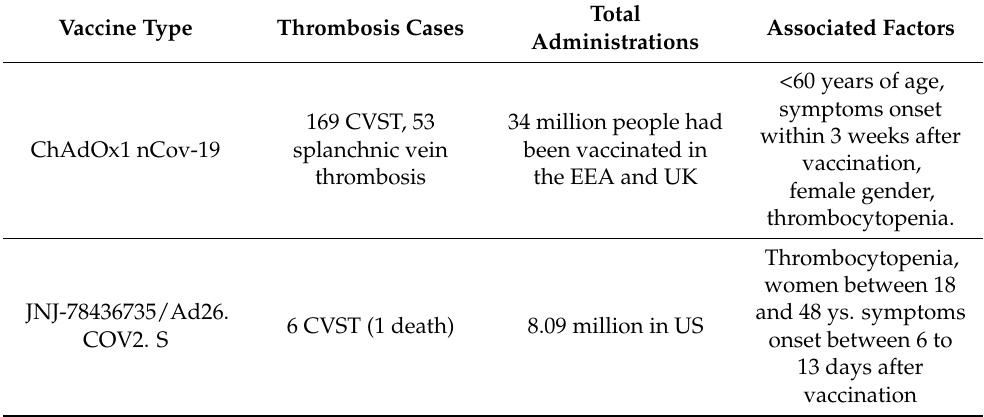
Table 3. Recent rare cases’ reports of thrombosis following administration of anti-SARS-CoV- 2 vaccines. Data for ChAdOx1 nCov-19 vaccine are reported by 4 April 2021. Data for